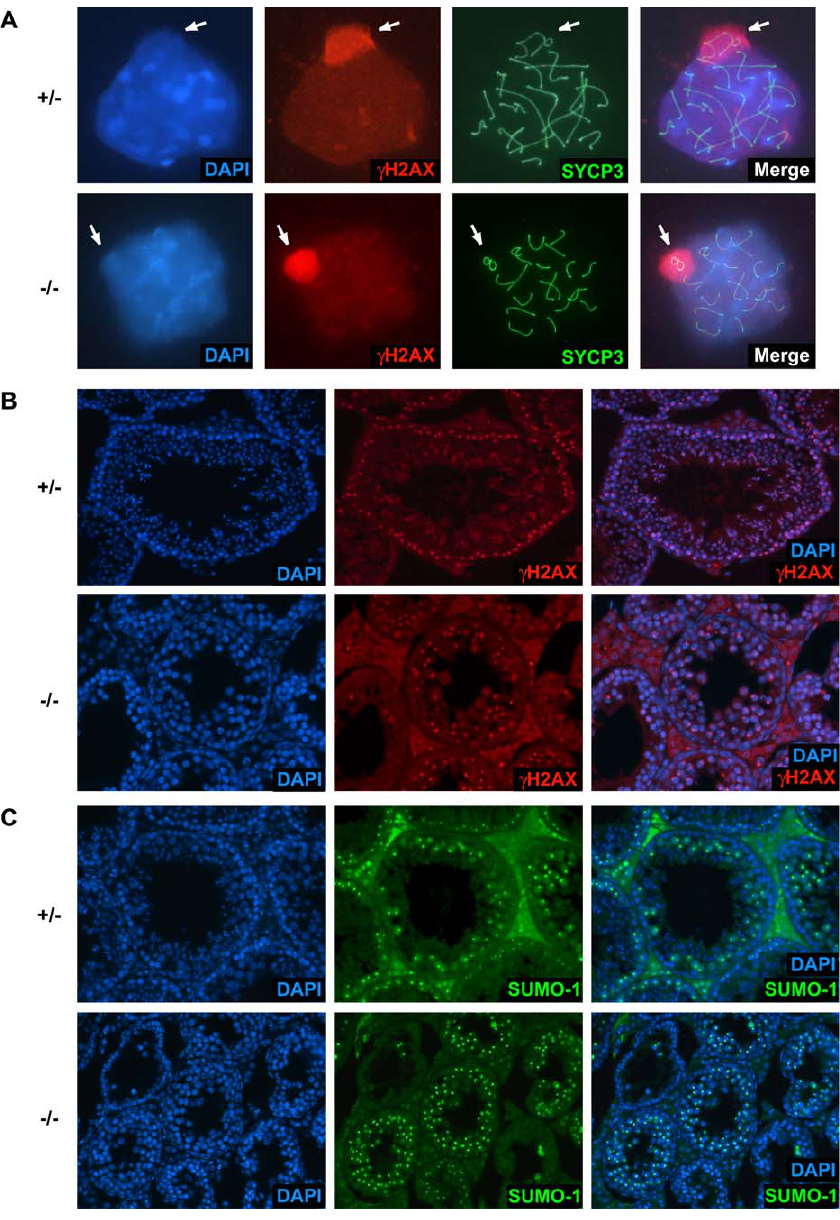
Figure 7. XY Body Forms Normally during Pachynema in Dmrt7 Mutant Mice (A) Testicular cells spread and stained with antibodies to c H2AX (red) and SYCP3 (green). In pachytene cells, c H2AX is concentrated in the XY body both in wild-type and Dmrt7 mutant. (B) Testes from 6-wk-old mice sectioned and stained with antibody to c H2AX (red). (C) Testes from 6-wk-old mice sectioned and stained with antibody to SUMO-1 (green). Abundant pachytene cells with XY bodies are present in wild- type and mutant testes.